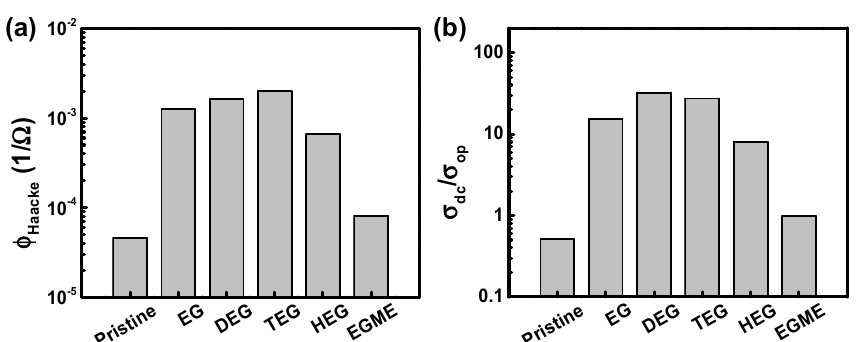
Figure 4. Figures of merit of the PEDOT:PSS films processed with additives. ( a ) The parameter proposed by Haacke. ( b ) The ratios of electrical conductivity to optical conductivity, at the wavelength of 550 nm.